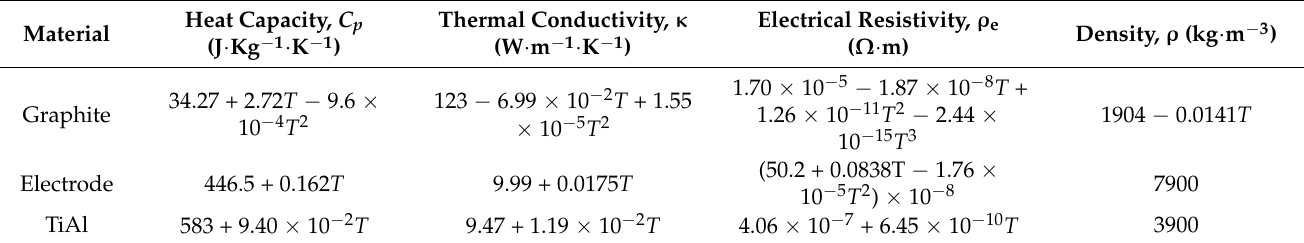
Table 1. The electro-thermal properties of materials used in this spark plasma sintering (SPS) setup [16,18]. Heat Capacity, C Material